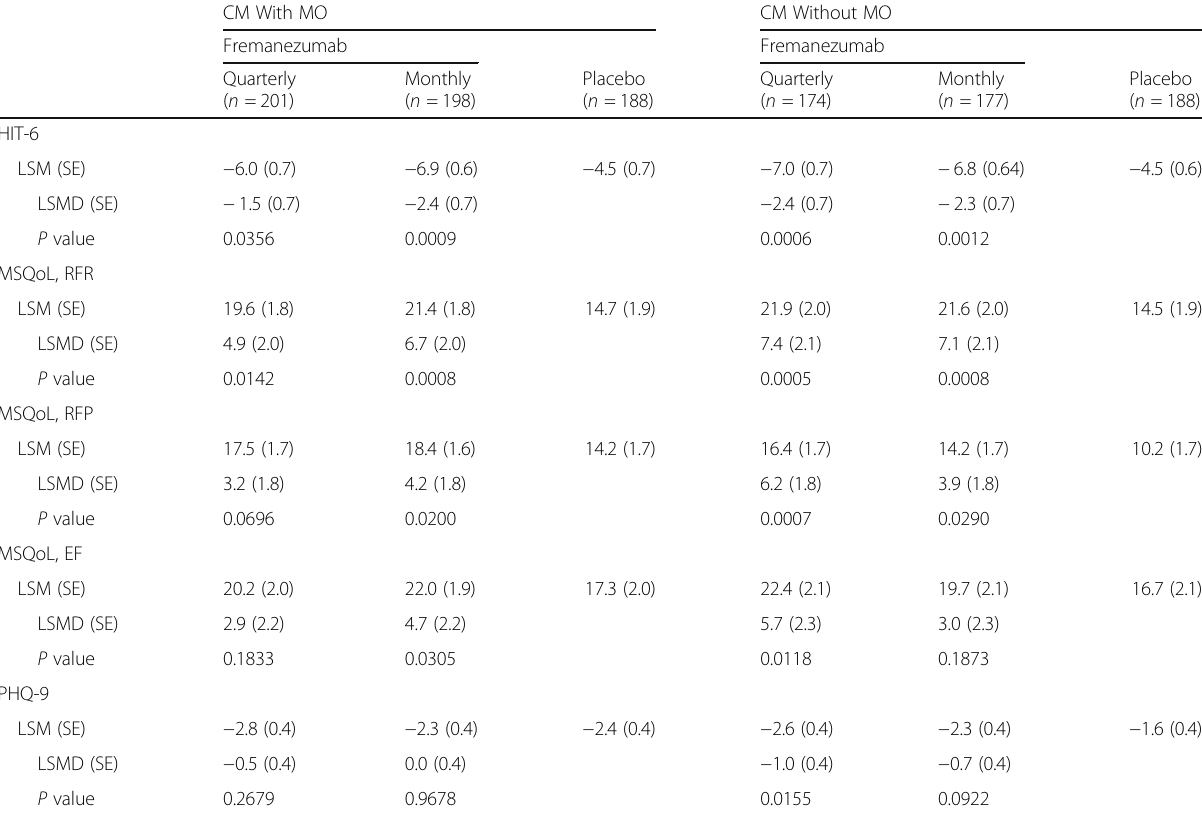
Table 2 Change from baseline in patient-reported outcome measures with and without MO CM With MO CM Without